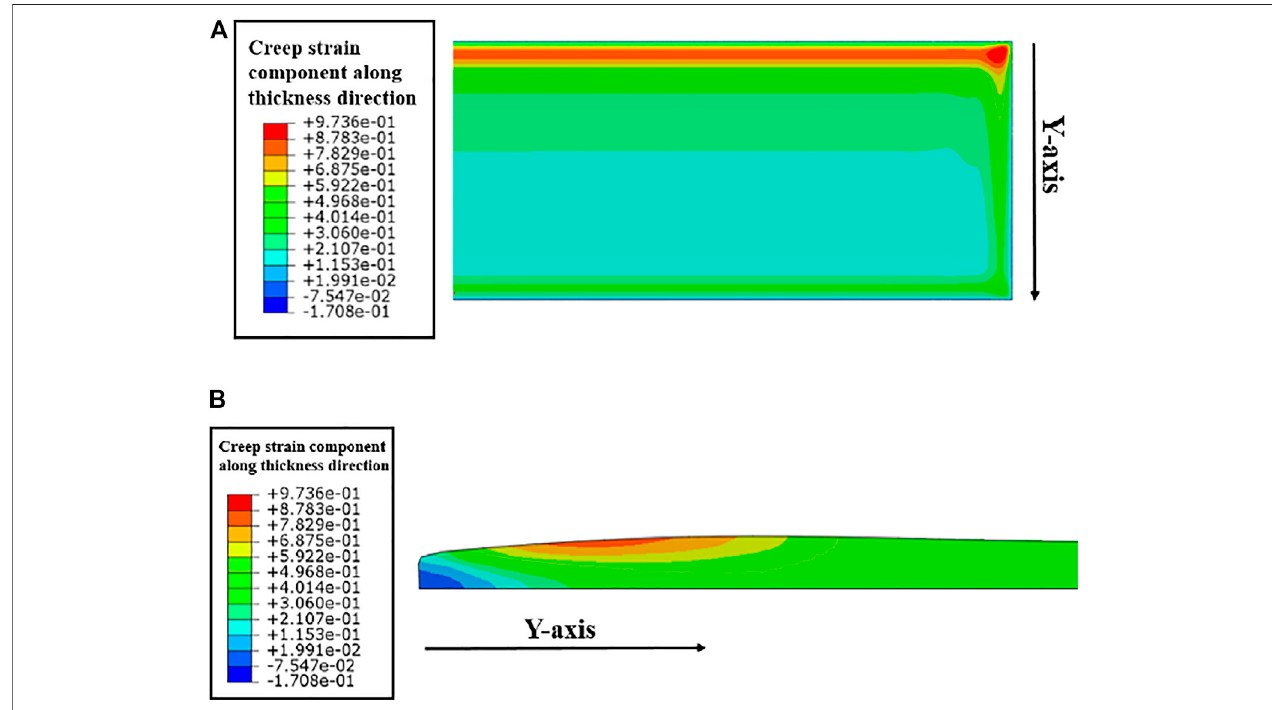
FIGURE 9 | (A) The distribution of the through-thickness creep component from the view of plate surface and (B) from the view of cross-section along the plate width.